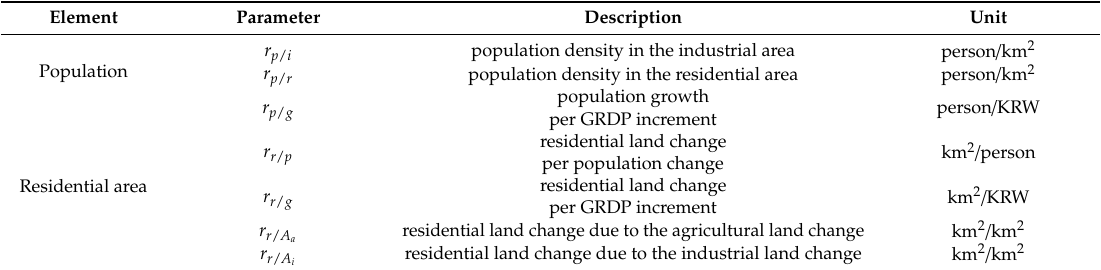
Table 3. Model calibration